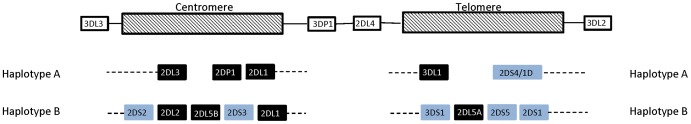
Schematic of KIR gene haplotypes A and B.white – framework genes, grey – activating KIR, black – inhibitory KIR; note that KIR2DP1 and KIR3DP1 are pseudogenes, and that KIR2DL2/2DL3 as well as KIR3DL1/3DS1 represent the same locus.